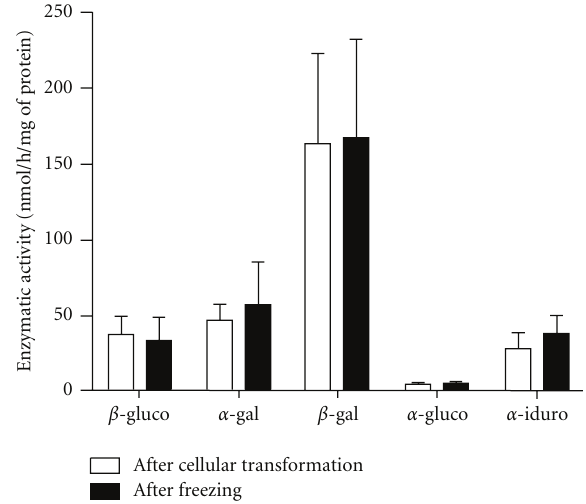
Figure 2: Enzymatic analysisof acid hydrolases from LCLs.Data are expressed as mean + standard deviation. β -gluco: β -glucosidase, α - gal: α -galactosidase, β -gal: β -galactosidase, α -gluco: α -glucosidase, and α -iduro: α